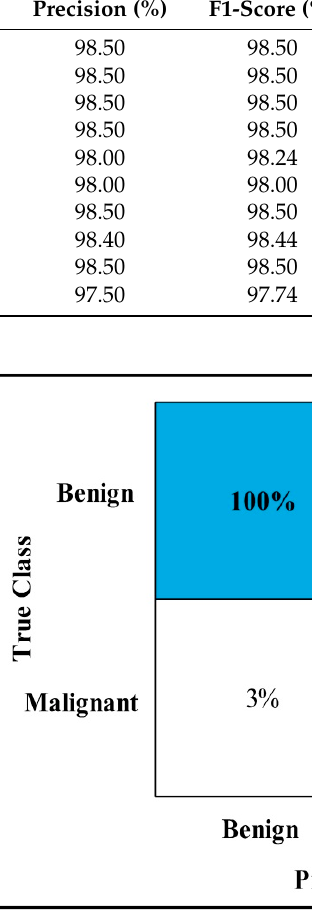
Figure 24. MEWOA on Fine-tuned Nasnet TPR for INbreast.